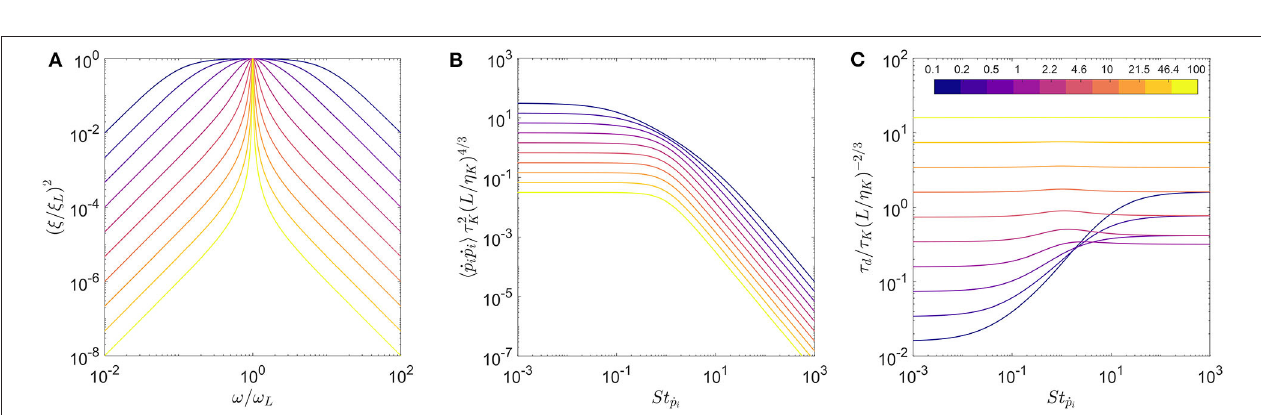
FIGURE 3 | The effect of quality factor ( Q ) on (A) the white noise spectrum, the transfer functions for (B) variance of tumbling rate and (C) correlation time scale. The colormap indicates the value of Q used for this computation.